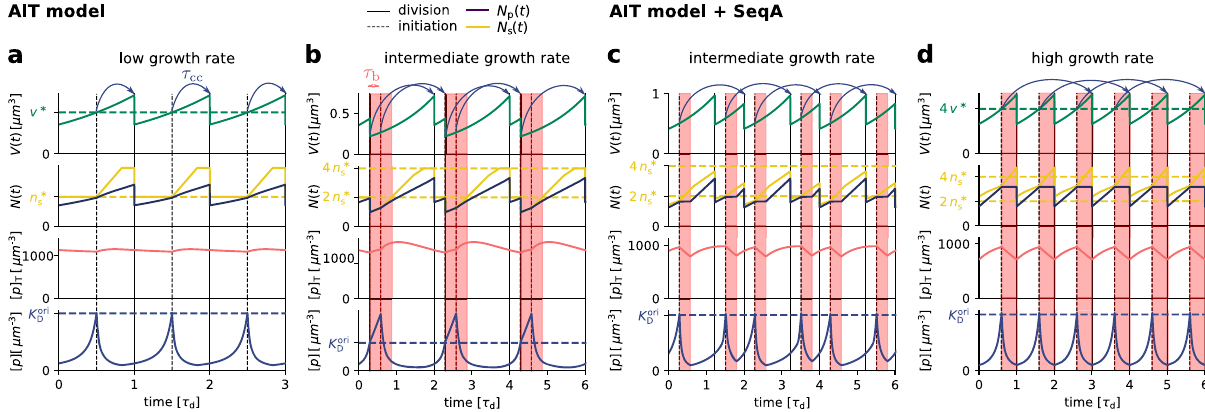
Fig. 2 | A titration-based model can generate robust replication initia- new initiator proteins and the free concentration [ p ]( t ) rapidly drops after initia- tioncyclesatlowgrowthrates,butnotathighergrowthratesintheregimeof tion. After a fi xed cycling time τ cc (blue arrows) the cell divides. The initiation overlapping replication forks. a – d The volume V ( t ), the number of initiator volume per origin v * (green dashed line) at low growth rates is constant in time. proteins N p ( t ) and titration sites N s ( t ), the total concentration of initiator proteins [ p ] T ( t ), and the concentration of initiator proteins in the cytoplasm [ p ]( t ) as a function of time (in units of the doubling time of the cell τ d ) for τ d =2h ( a ), τ τ d =35 min ( b , c ) and d =25 min ( d ), respectively. a When the number of initiator proteins per origin n p ( t ) exceeds the number of titration sites per origin n s (yellow dashed line), the free concentration [ p ]( t ) rapidly rises to reach the threshold concentration K ori D (blue dashed line), initiating a new round of replication. Due to the homogeneous distribution of titration sites on the chromosome of E. coli and tion (shaded red area), prevents reinitiation events at high ( d ) but not at inter- the constant DNA replication rate, the number of titration sites then increases mediate growth rates ( c ). (See Supplementary Table 1 for all linearly in time. At low growth rates, new titration sites are synthesized faster than